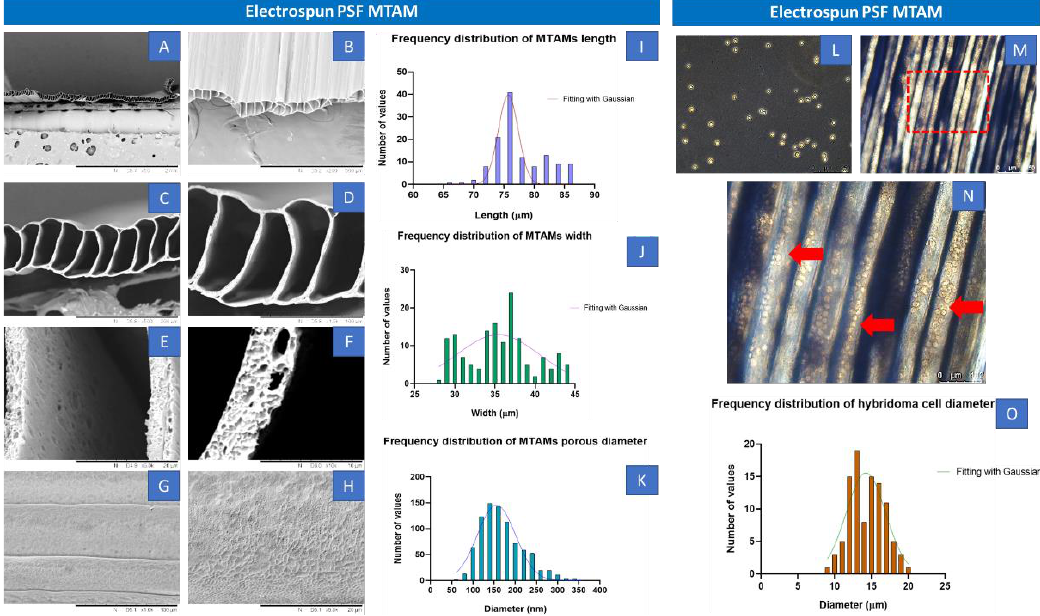
Figure 1. ( A – F ) Transverse view of the SEM images of electrospun PSF MTAMs at increasing magnification (50×, 200×, 500×, 1000×, 5000× and 10,000×) and ( G , H ) Top view of the SEM images at a magnification 1000× and 5000×. The lumen dimensions of the electrospun PSF MTAMs were about 77.54 ± 4.3 µm × 35.64 ± 4.2 µm (height × width), with a lumen wall thickness of about 4.70 ± 0.3 µm, and a pore size of 167.75 ± 50 nm. ( I – K ) Distribution of the MTAM length, width and pore size. ( L ) Optical microscopy images of the hybridoma cells cultured on TCPs, as reference. ( M , N ) Optical microscopy images of the PSF MTAMs loaded with hybridoma. ( O ) Distribution size of the hybridoma that were loaded in the PSF MTAMs which averages around 14.4 ± 0.4 µm in diameter( n = 6).